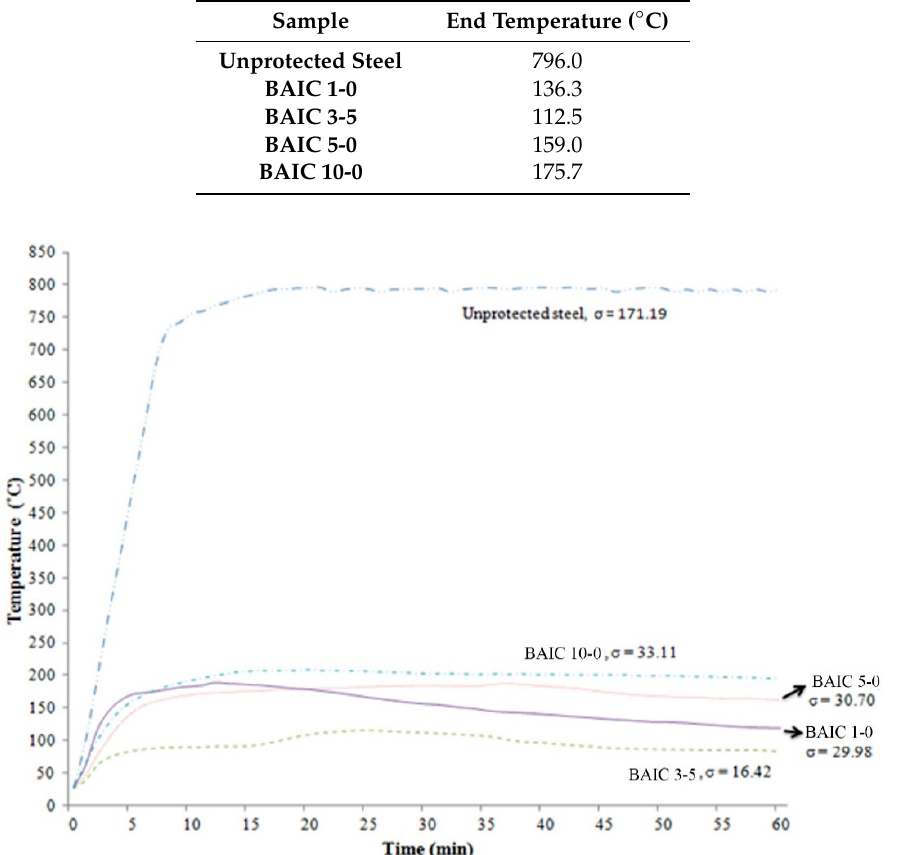
Table 2. End temperatures of BioAsh intumescent coating (BAIC) samples.